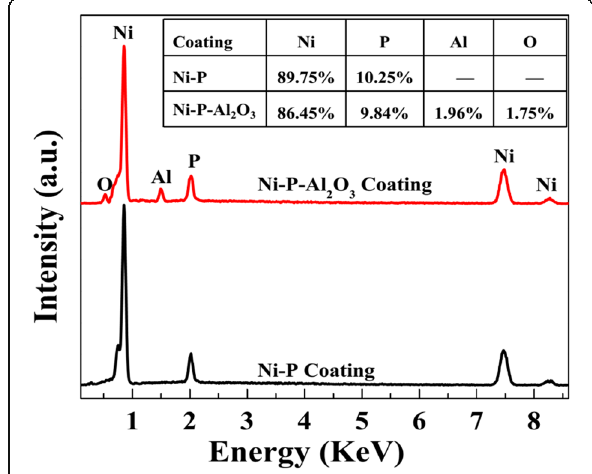
Fig. 7 The EDS spectra of the Ni-P coating and the Ni-P-Al 2 O 3 composite